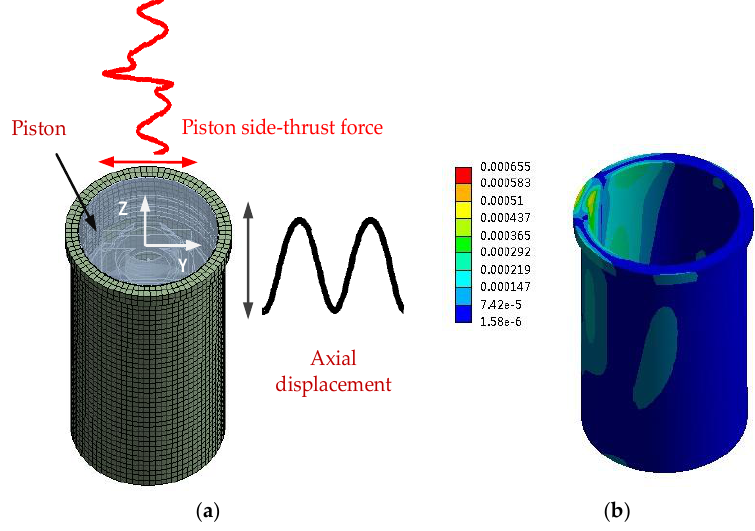
Figure 4. ( a ) Excitation configurations; ( b ) Total deformation of cylinder liner (Unit: mm).